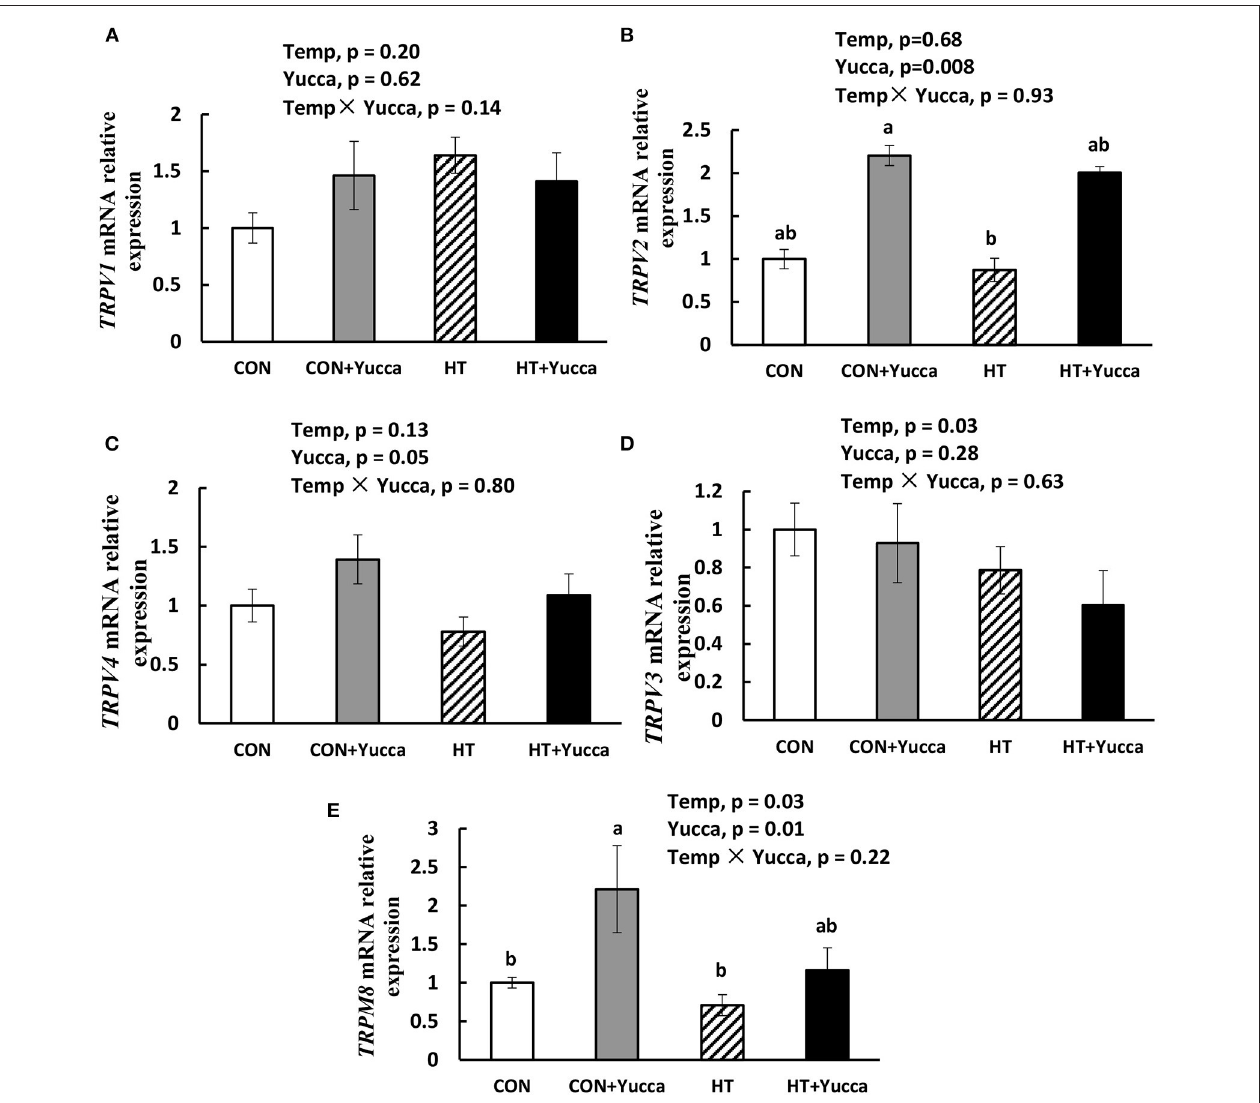
FIGURE 2 | Hypothalamic mRNA expression of TRPV1 (A) , TRPV2 (B) , TRPV4 (C) , TRPV3 (D) , and TRPM8 (E) in broilers at 56 days. Broilers, of 28 days of age, were fed a basal diet and exposed to 24 ◦ C (CON) or 34 ◦ C (HT), or a basal diet supplemented with 0.1% yucca and exposed to 24 ◦ C (Yucca) or 34 ◦ C (HT + Yucca) for 4 wks. Values are means ± SE, n = 6. Means without a common letter differ ( P < 0.05).